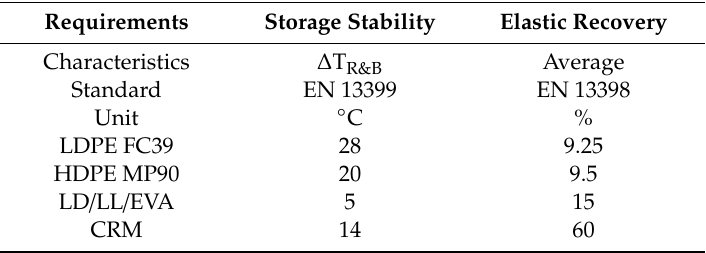
Table 7. Storage stability and elastic